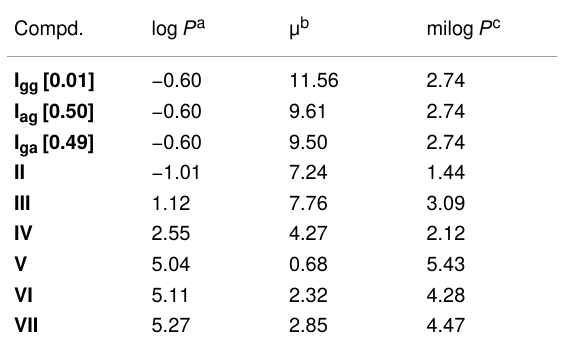
Table 2: Experimental log P , dipole moment ( μ , in Db), and predicted log P of agrochemicals I – VII .